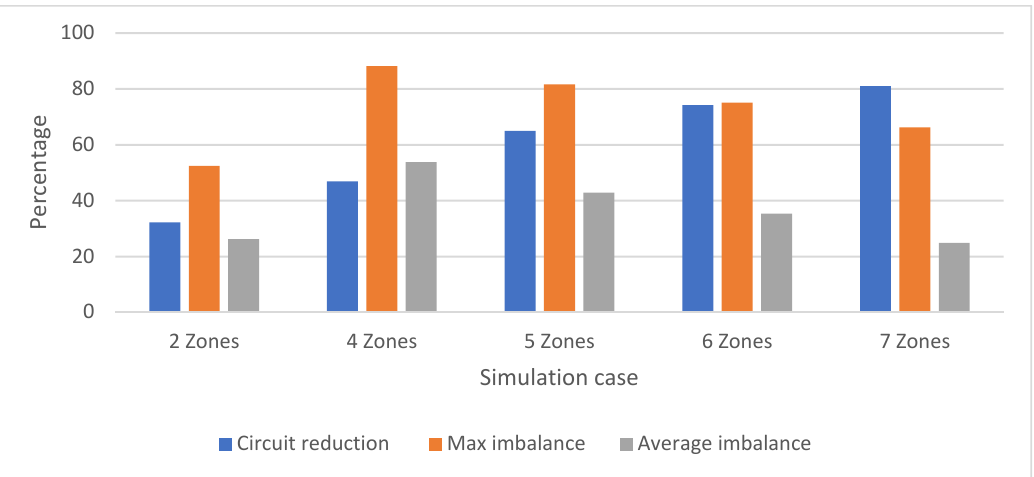
Figure 6. Simulation time reduction as a percentage of the reference.